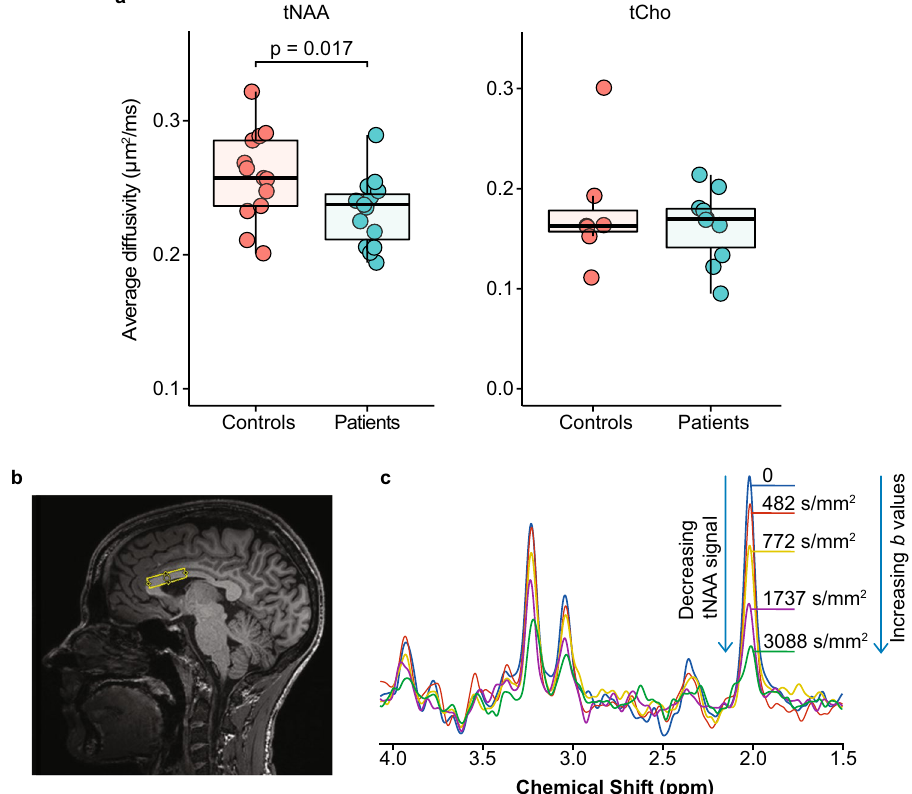
Figure 3. Diffusivity of metabolites and the representation of diffusion-weighted magnetic resonance spectroscopy (DW-MRS) acquisition. ( a ) Average diffusivity of total N -acetylaspartate (tNAA) and total choline (tCho) between patients and controls. Significantly lower average diffusivity of tNAA was observed in patients with HD while no difference in diffusivity was observed in tCho. ( b ) Position of the 15 × 32 × 8 mm 3 voxel for DW-MRS acquisitions in the corpus callosum. ( c ) Signal attenuation in relation to an increase in the b values used in DW-MRS acquisitions.